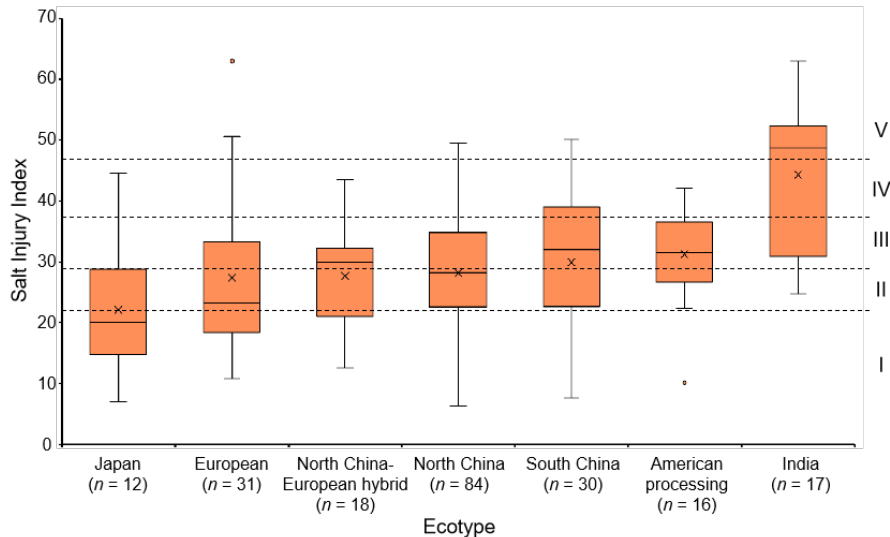
Figure 3. The box plot depicting the salt injury index of different ecotypes. The I, II, III, IV, and V indicates Group I, Group II, Group III, Group IV, and Group V, respectively. The dot represents the outlier. The cross represents the mean.